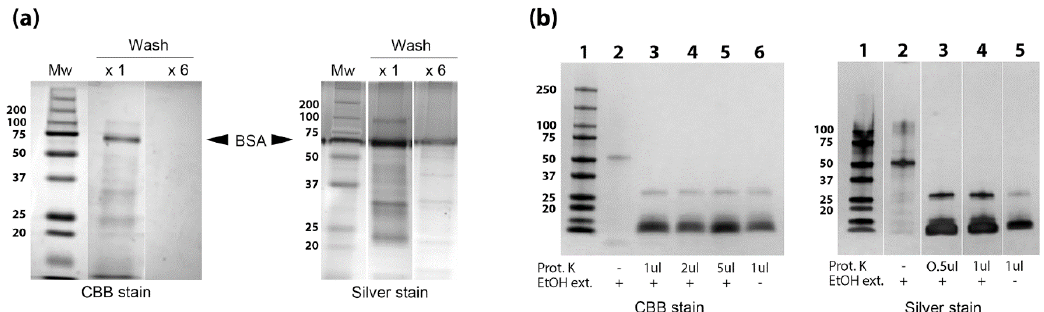
Figure 6. Preparation of EtOH extract for mass spectrometry analysis. ( a ) Map bacilli were washed 6 times prior to EtOH extraction (labeled × 6) to avoid bovine serum albumin (BSA) contamination. A second extract was prepared after washing Map once (label × 1). Lipids and carbohydrate were removed from the EtOH extract through a second chloroform:methanol:water extraction. This second extraction was run on 12% SDS-PAGE denaturing gels and exposed to Coomassie stain (CBB) and silver stain. The location of BSA migration is identified for both gel images. ( b ) Proteinase K treatment of Map EtOH extract. Inclusion of proteinase K or the EtOH extract along with staining method is indicated beneath the gel. Kilodalton size markers are shown in the left margins of all gels.